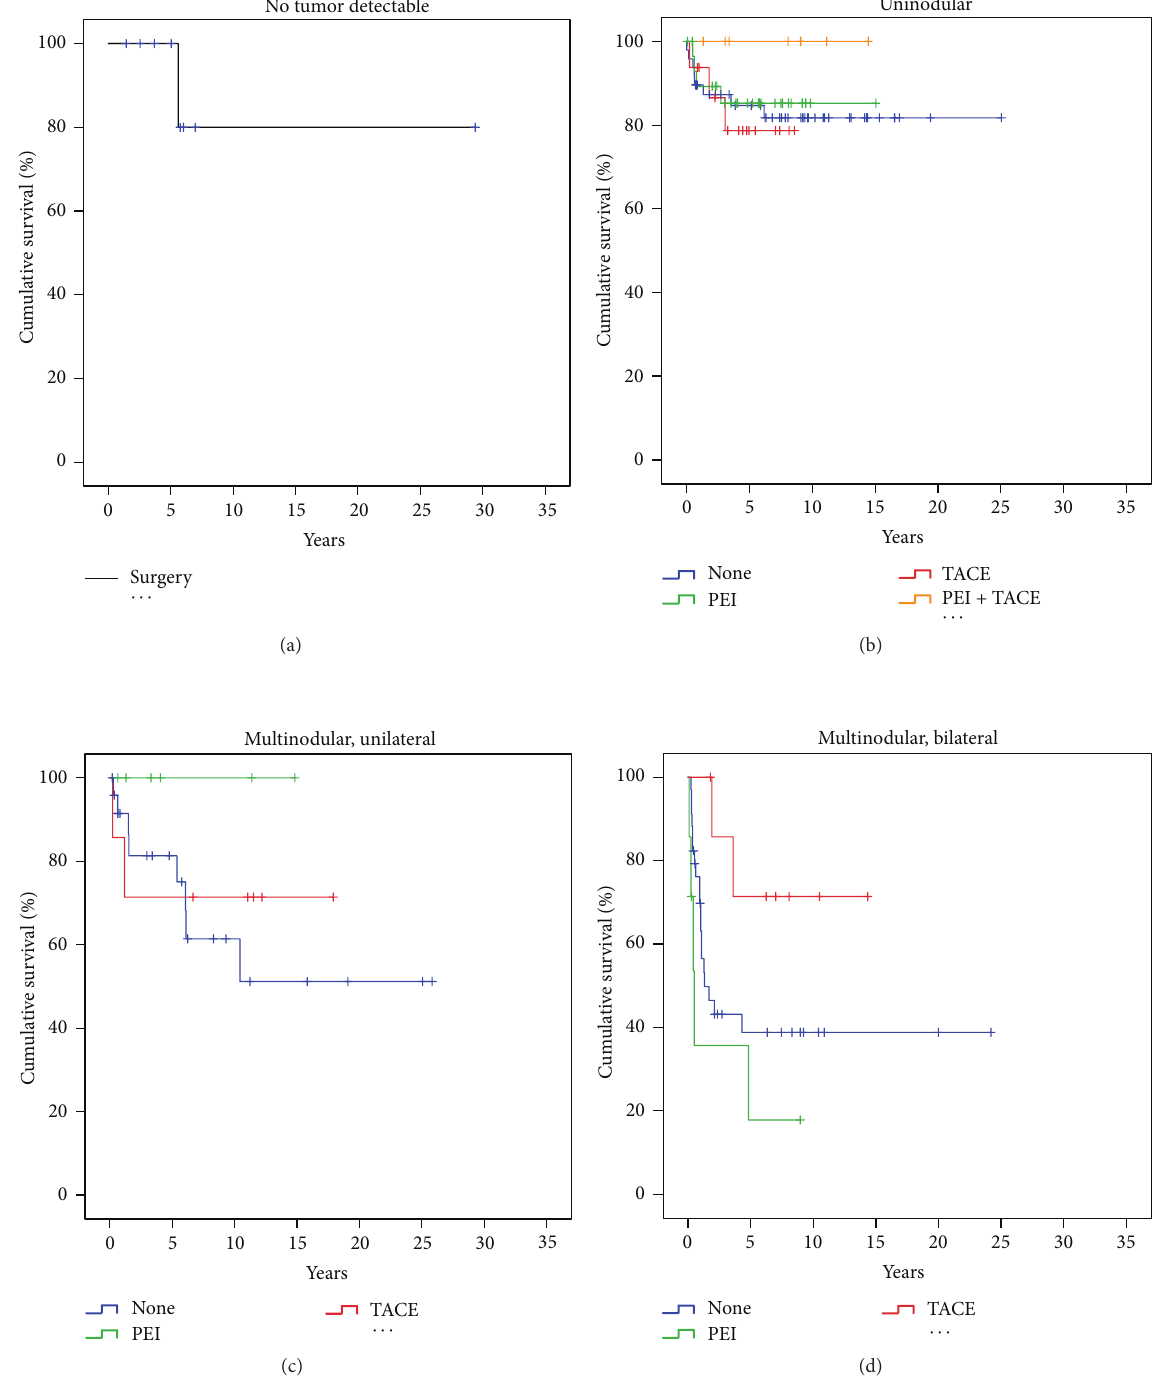
Figure 7: Survival with respect to tumor morphology and neoadjuvant therapy. Hospital mortality and non-HCC recurrence related deaths as well as treatment groups with 𝑛 < 5 were excluded. In the category of nondetectable tumors only surgery remained with 𝑛 > 5 . The cumulative survival in this subcategory was 80% (a). In the category of uninodular HCC (b) there was no difference in survival comparing patients that had been pretreated by PEI or TACE . For the combination of PEI and TACE a significantly better survival was observed (Log Rank 𝑝 < 0.05 ) as compared to PEI or TACE alone. For multinodular/unilateral HCC (c) TACE did not make a difference, while pretreatment with PEI achieved a significant better survival (Log Rank 𝑝 < 0.05 ). In multinodular/bilateral tumors (d) survival was significantly better for the group of patients who were pretreated with TACE as compared to PEI or no